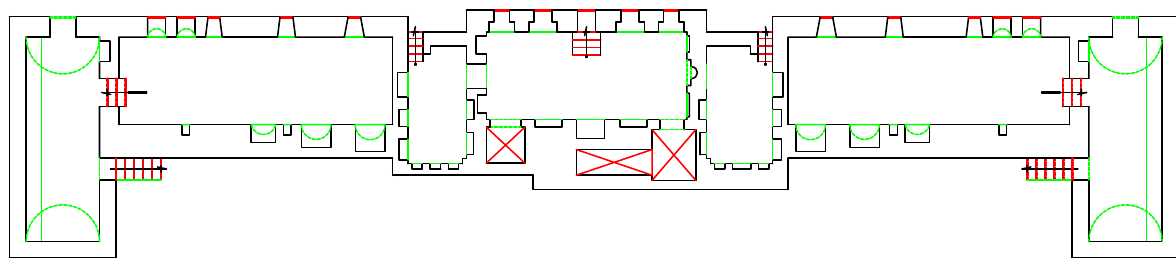
fig. 6. Plan of first floor of buildings type two (created by author)